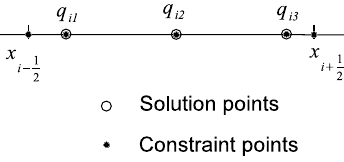
Figure 1. Configuration of DOFs and constraint conditions in a one- dimensional